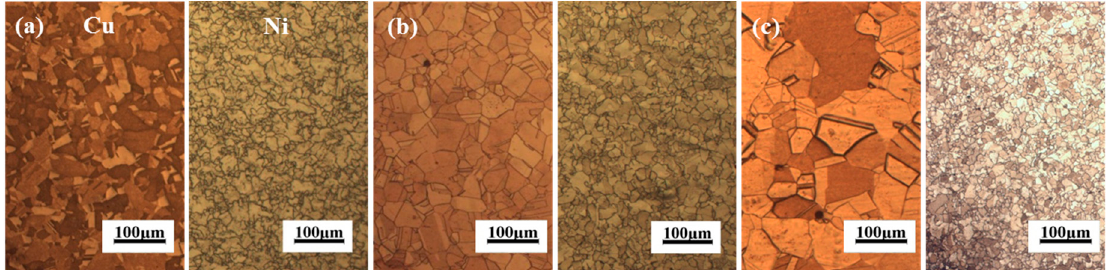
Figure 1. Cross-section along the rolling direction of the specimen.